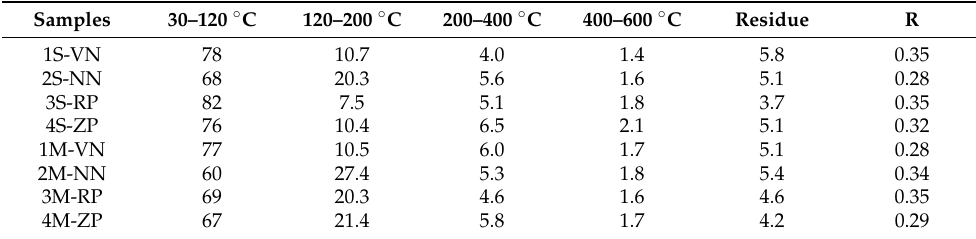
Table 2. TGA analysis of fresh peach and nectarine mesocarp samples. Values expressed as weight loss percentage (%; instrumental sensitivity, 0.5%). R parameter, ratio among the weight loss in 400–600 ◦ C and 200–400 ◦ C ranges, is also